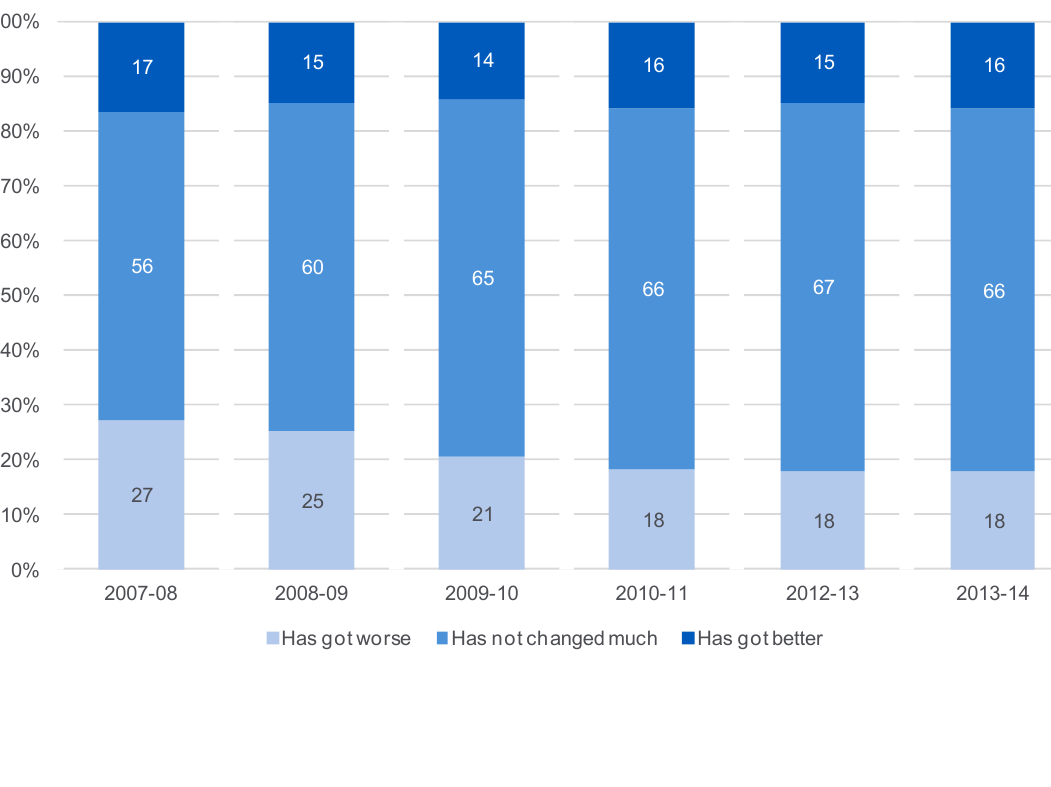
Table 21: Whether people think that their local area has got better or worse to live in over the past two years, 2007-08 to 2013-14